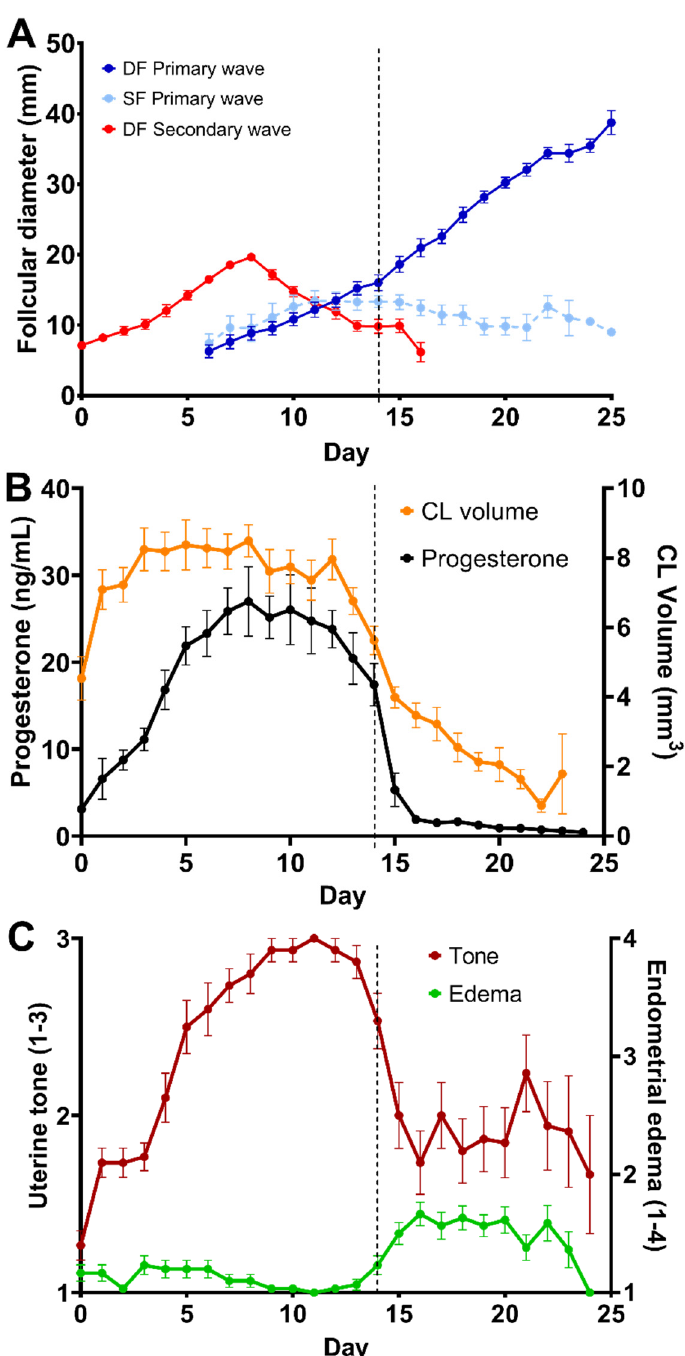
Figure 1. Mean ± SEM of ( A ) follicular growth in the primary and secondary waves, ( B ) endometrial edema and uterine tone scores, and ( C ) volume of corpus luteum and serum progesterone concentrations in four estrous cycles of Caribbean jennies (n = 8). Dashed line indicates the follicular divergency. The CL volume was calculated according to the formula for the volume of an ellipsoid, 4/3. 𝜋. 𝑎. 𝑏. 𝑐 , where a = half of the longest dimension and b = c = the radius of the ‘waist’ or widest part of the CL. Uterine tone (1 to 3; 1: flaccid and 3: turgid) and endometrial edema (1: minimal edema to 4: exacerbated edema) scores [28] were evaluated by transrectal digital palpation and ultrasonography, respectively.